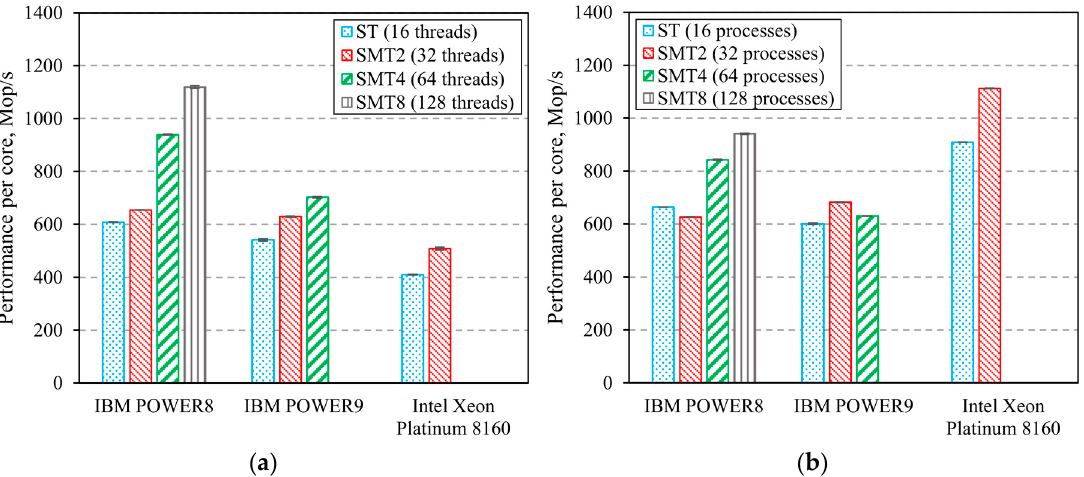
Figure 6. CG Class C benchmark results: OpenMP version ( a ) and MPI version ( b ).